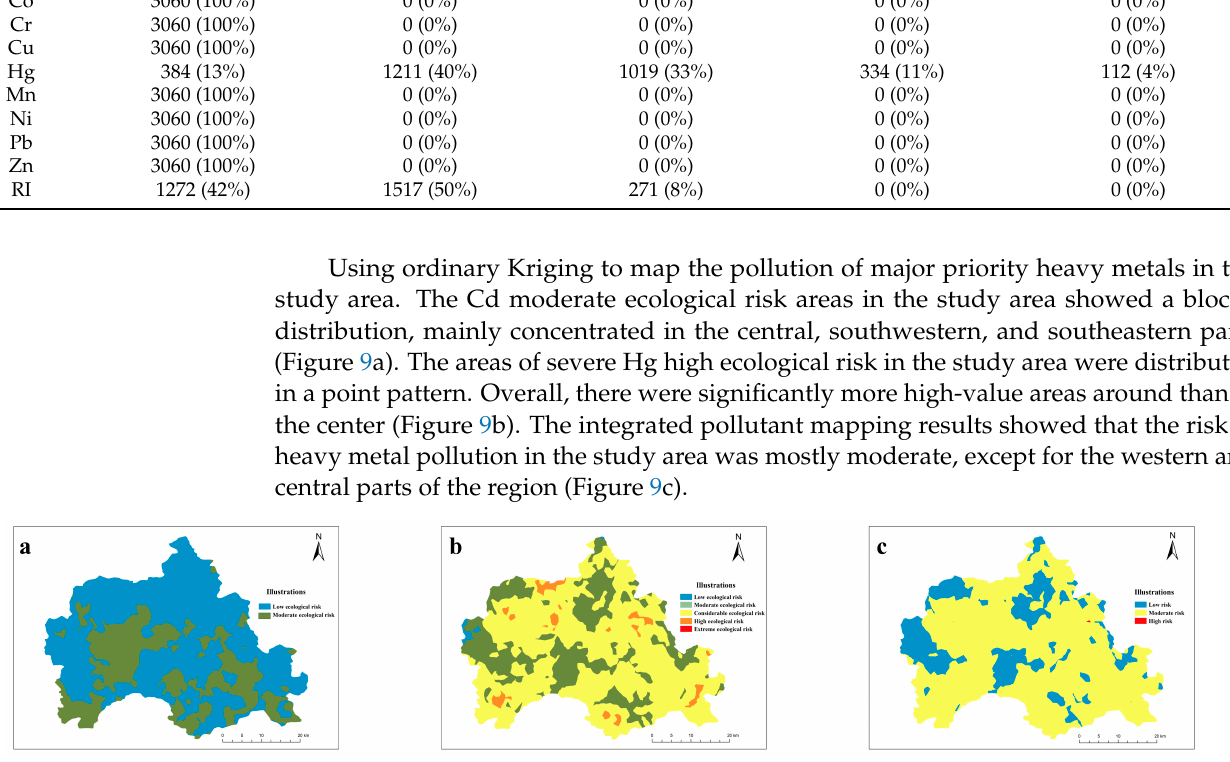
Table 7. The result of the percentage of E r and RI grades.